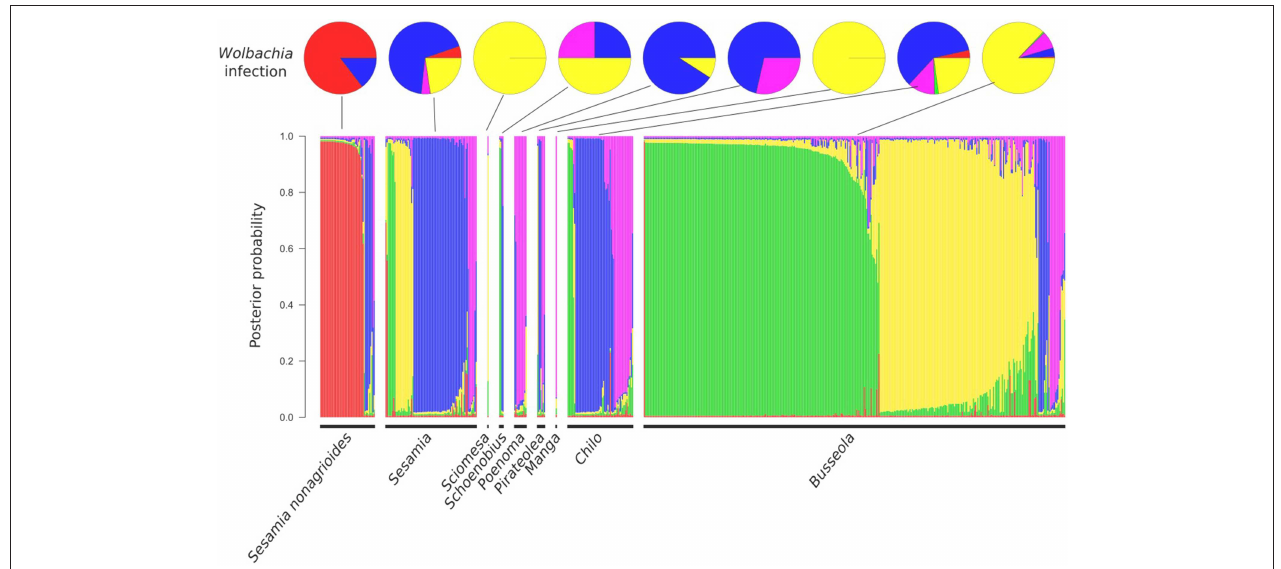
FIGURE 1 | Top: Pie charts representing the proportion of each infection found on each host genus (WCses A in red; WCses B1 in yellow; WCses B2 in green; WCses A/ WCses B2 in blue; Absence in magenta). Bottom: Posterior probability of admixture proportion of each individual of Cotesia sesamiae wasps to each of the 5 Instruct clusters and post-processed with CLUMPP (Cluster 1 in red, cluster 2 in yellow, cluster 3 in green, cluster 4 in blue, cluster 5 in purple). Individuals are grouped by the host genus where they were found. Individuals found on an unidentified host are not